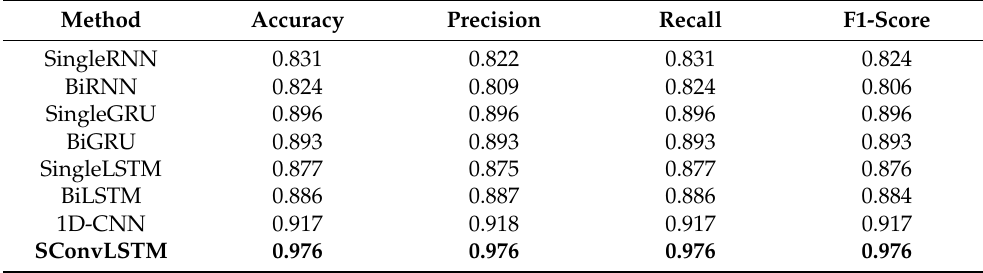
Table 4. Classification performance of proposed method and some based on deep learning methods on HuGaDB dataset.